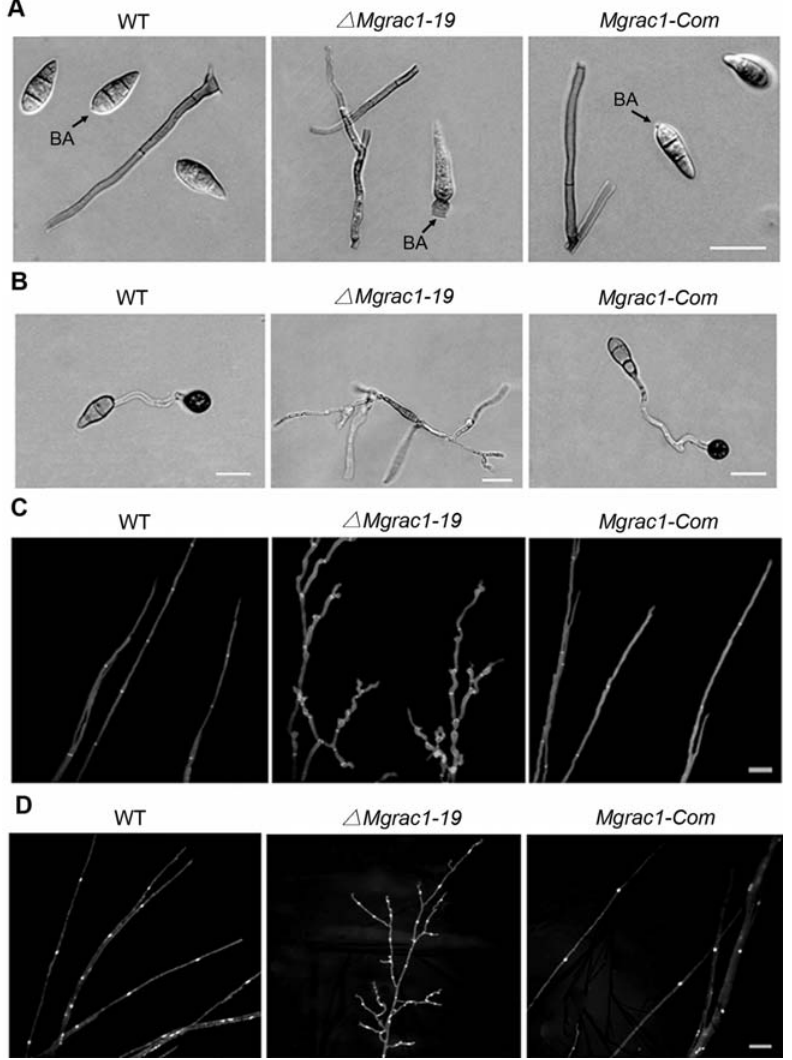
Figure 2. Abnormal conidial morphology, appressorial formation, and hyphal branching in the Mgrac1 deletion mutant. (A) Differential interference contrast (DIC) microscopy of conidia cultured on an oatmeal agar plate at day 10 after incubation. BA=basal appendage where conidia attach to conidiophores. Bar=20 m m. (B) Conidia incubated on the surface of artificial hydrophobic Gelbond films as described in Materials and Methods. Bar=20 m m. (C) Branching patterns of mycelia on complete media plates at day 3 after incubation. Frequent branching occurs at the terminal mycelia of D Mgrac1-19 . Calcofluor staining of mycelia is used to show the distance of septa. Bar=20 m m. (D) DAPI staining of mycelia to show the localization of nuclei. Bar=20 m